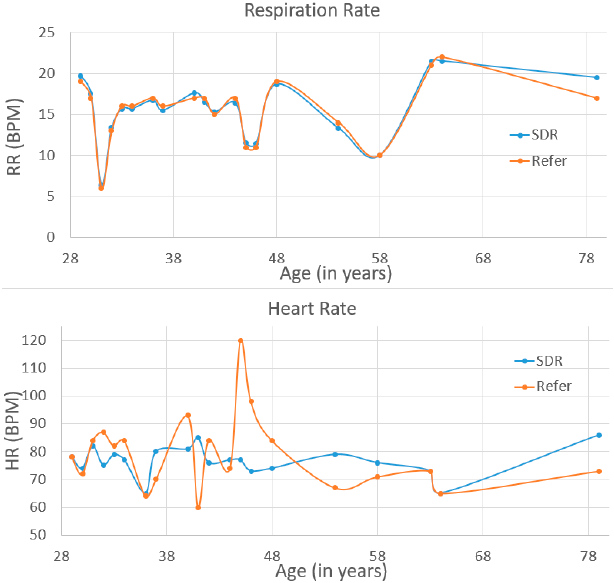
Figure 11. NCVS clinical trial test data on 20 cases sorted by height.